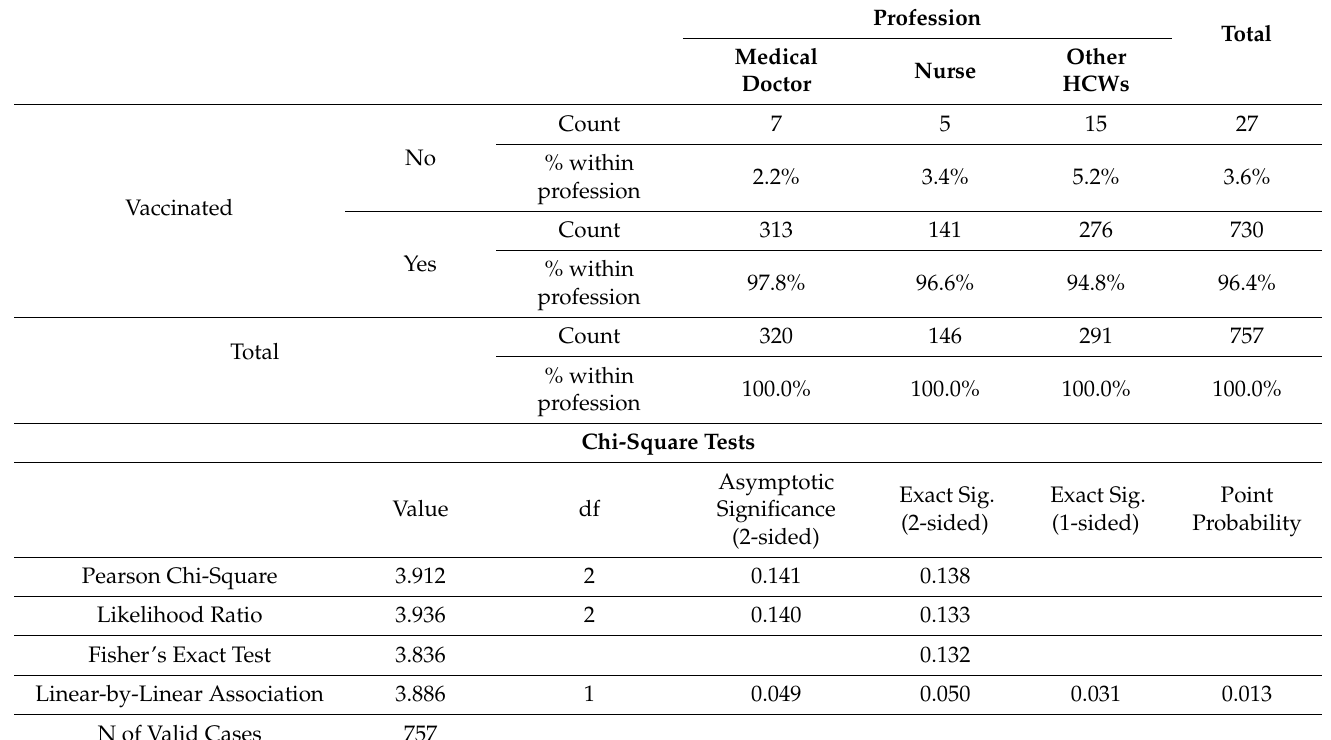
Table 4. Rate of vaccine uptake by job